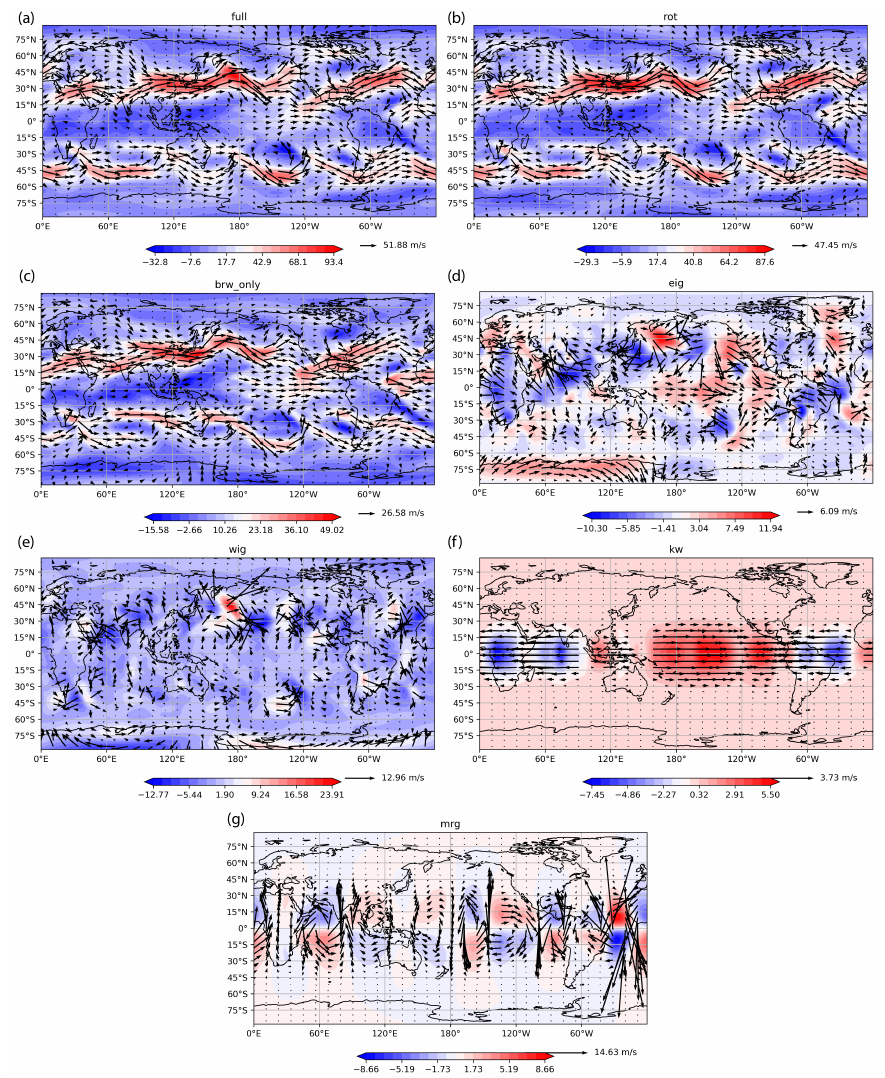
Figure 3. Snapshot of the horizontal velocity and geopotential fields at 200 hPa ( a ) and their decom- position on the normal mode function basis for rotational modes ( b ), the baroclinic component of the rotational modes ( c ), eastward inertio gravity (EIG) modes ( d ), westward inertio-gravity modes ( e ), Kelvin wave mode, ( f ) and mixed Rossby-Gravity mode ( g